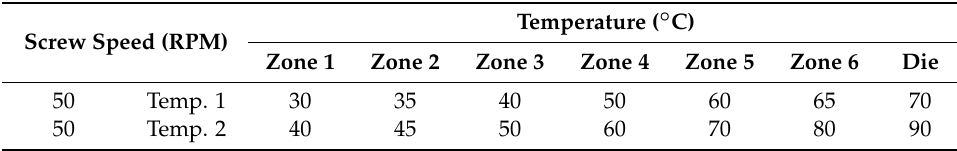
Table 2. Extrusion conditions used to examine the effect of temperature variations in processing of a novel SSB ® 55 Pharma grade